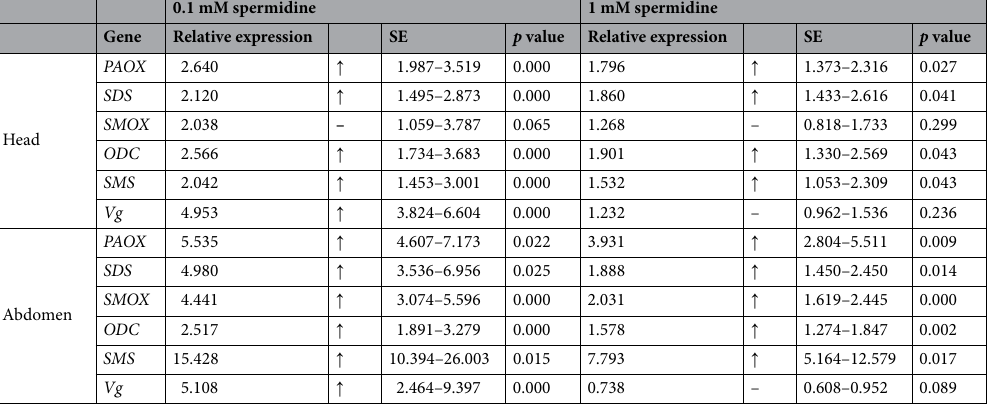
Table 1. Relative expression and standard error (SE) for genes ornithine decarboxylase ( ODC ), spermidine synthase ( SDS ), spermine synthase ( SMS ), spermine oxidase ( SMOX ), polyamine oxidase ( PAOX ) and vitellogenin ( Vg ) in head and abdomen of bees whose diet was supplemented with 0.1 mM and 1 mM spermidine for 17 days compared to control, fed only sucrose. The difference in the analyzed gene expression was calculated by REST 2009 and tested for statistical significance by the integrated Bootstrap randomization test between the control and target groups. The results of expression of the investigated transcripts for each sample were tested for significance by a Two-sided Pair Wise Fixed Reallocation Randomisation Test © . Statistically significant difference compared to the control group is indicated with an arrow ↑ ( p <